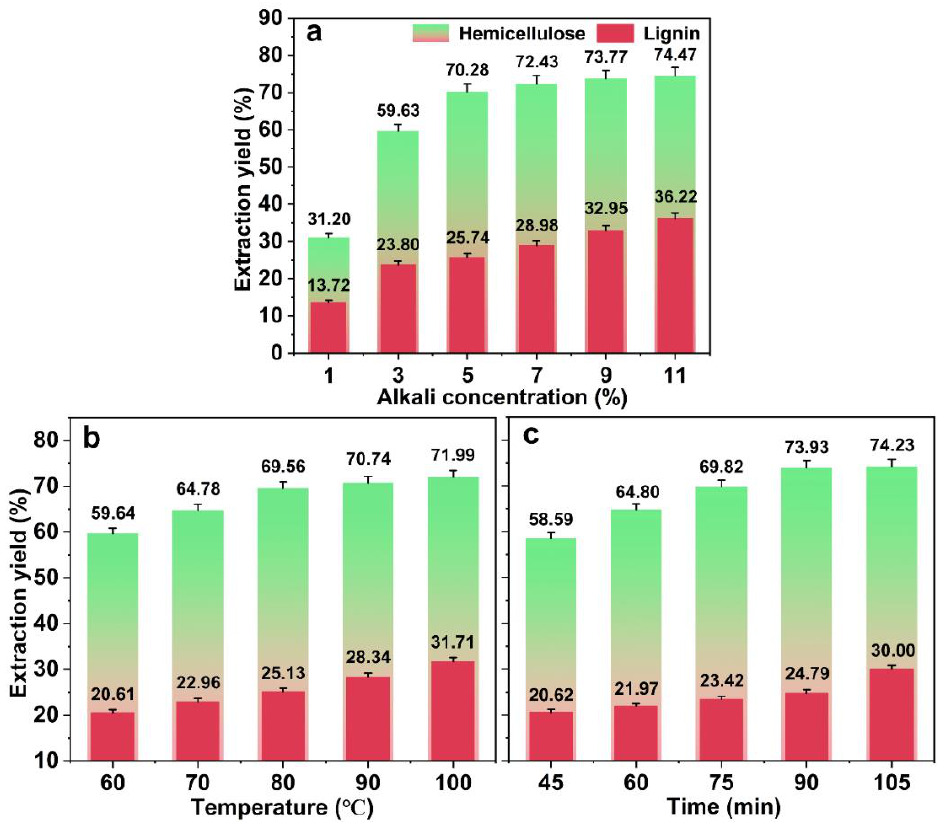
Figure 2. Effect of the alkali treatment on the extraction yield of hemicellulose and lignin (( a ), effect of alkali concentration; ( b ), effect of temperature. ( c ), effect of time. The error bars represent the mean ± SD of samples over three replicates).